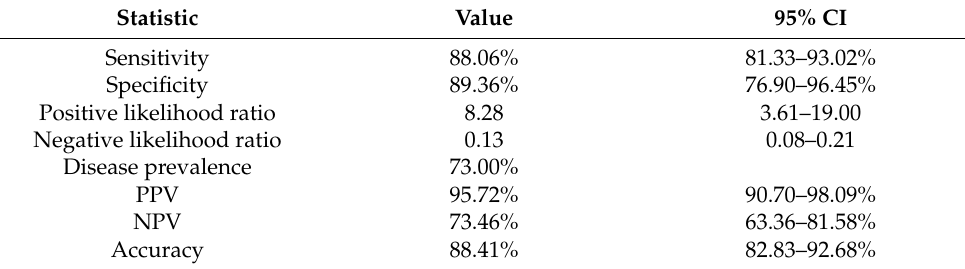
Table 6. LI-RADS-4 and 5 accuracy for HCC.